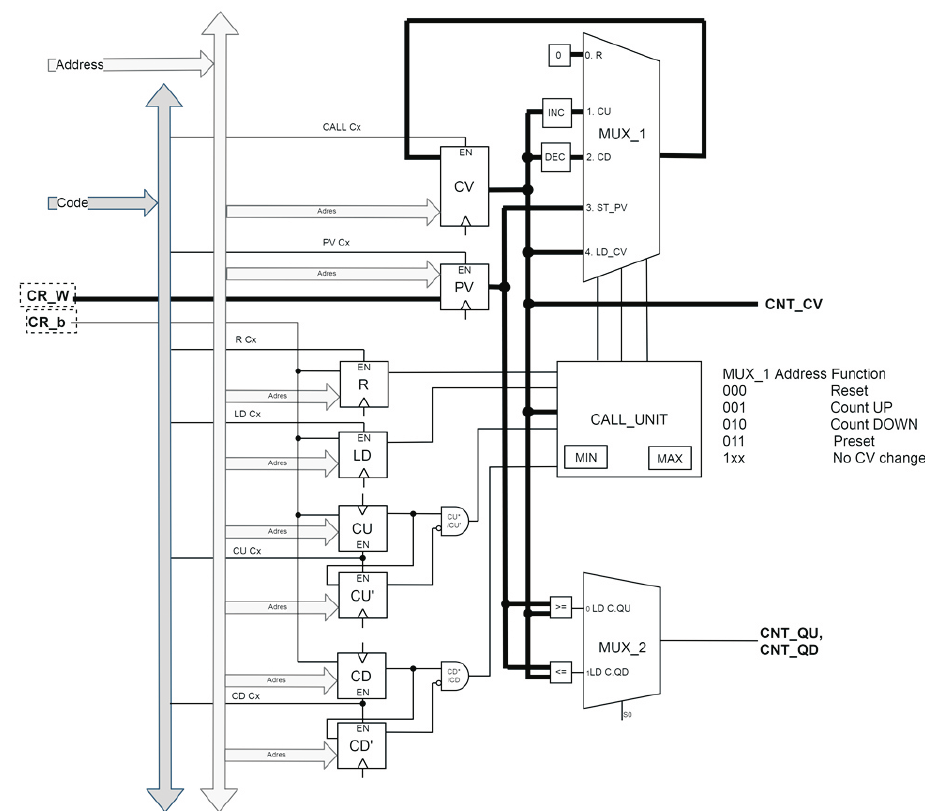
Figure 13. The structure of the soft-like counter block with a